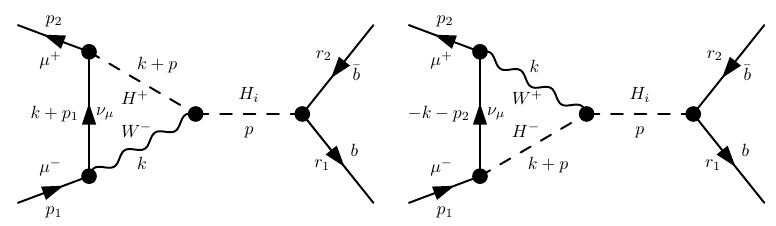
Figure 17 . Two Feynman diagrams for the toy process (cid:22) + (cid:22) (cid:0) ! (cid:22) bb involving scalar-scalar-vector vertices which give rise to gauge-dependent as well as additional gauge-independent pinch contribu- tions for the CP-even self-energies. The momenta p 1 and p 2 are taken as incoming and the momenta r 1 and r 2 as outgoing, and p = p 1 + p 2